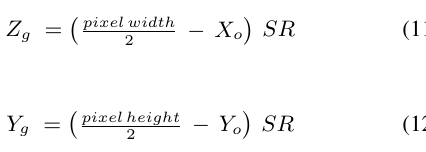
Figure 6. Image coordinate system ( C ), the gimbal frame ( G ) projected and detected object ( O